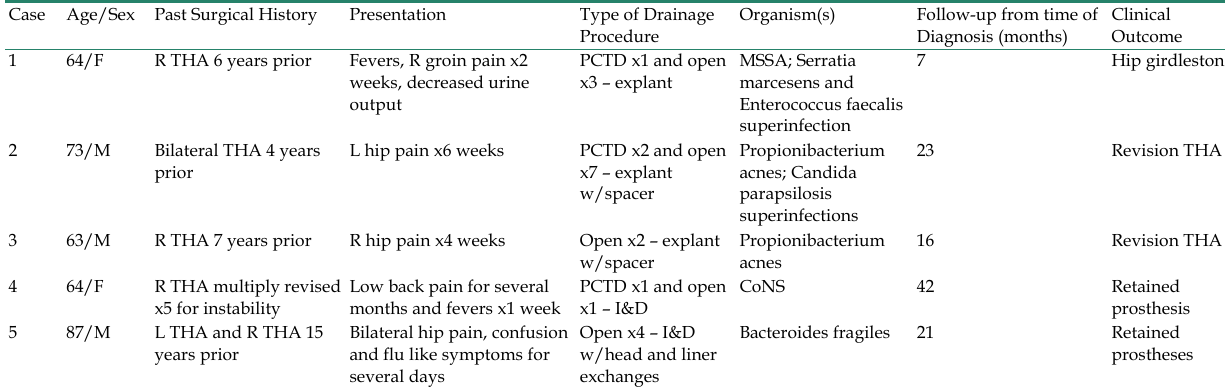
Table 1. Case data and